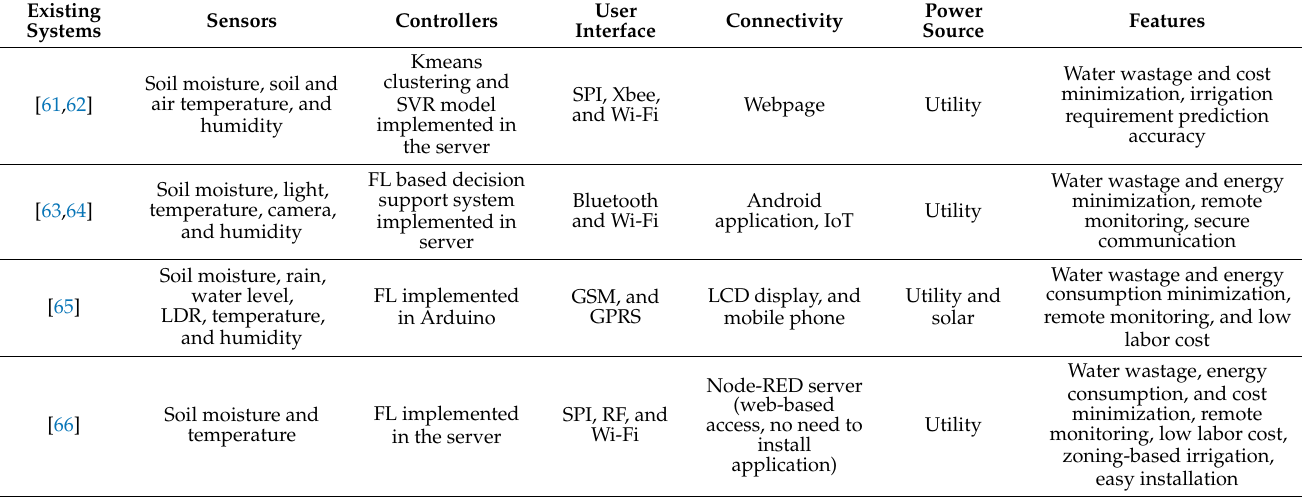
Table 1. A brief comparison of some recent literature on developed systems and proposed system for